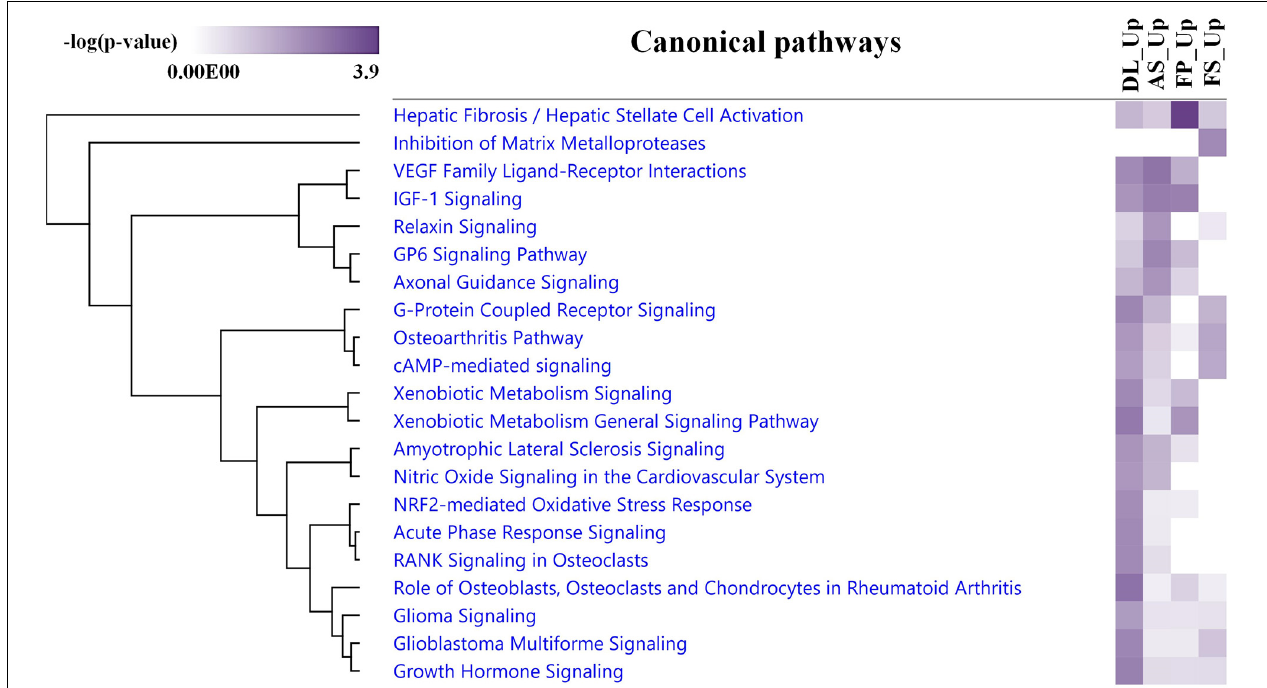
FIGURE 6 | An IPA comparison analysis of the related canonical pathways of DEGs between the upregulated DEGs in each breed and synovial tissue source. Related canonical pathways were hierarchically clustered and displayed with a heat map according to the negative log of the Fisher’s exact test p -values.